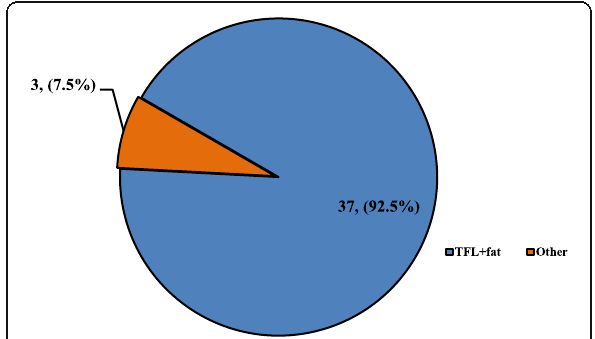
Fig. 2 Type of graft (other: TFL and bone, bone and fat, and tensor fascia